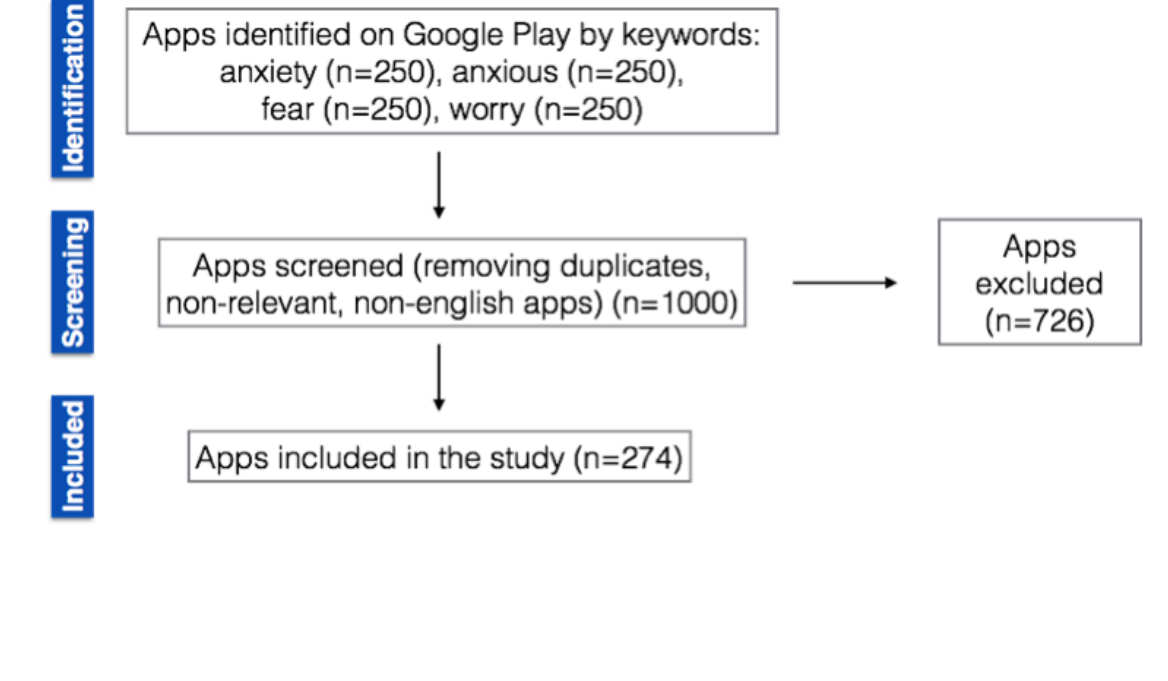
Figure 2. Systematic search of anxiety-related apps on Google